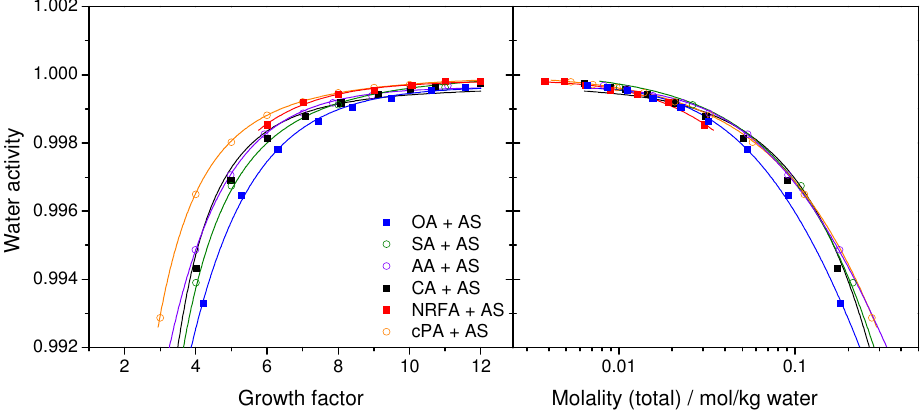
Fig. 3. Measured water activity of the 50:50 mixtures containing an organic acid and ammonium sulphate (abbreviations are explained in Table 1). Continuous lines based on empirical fits (see Table 3) are included to aid visual